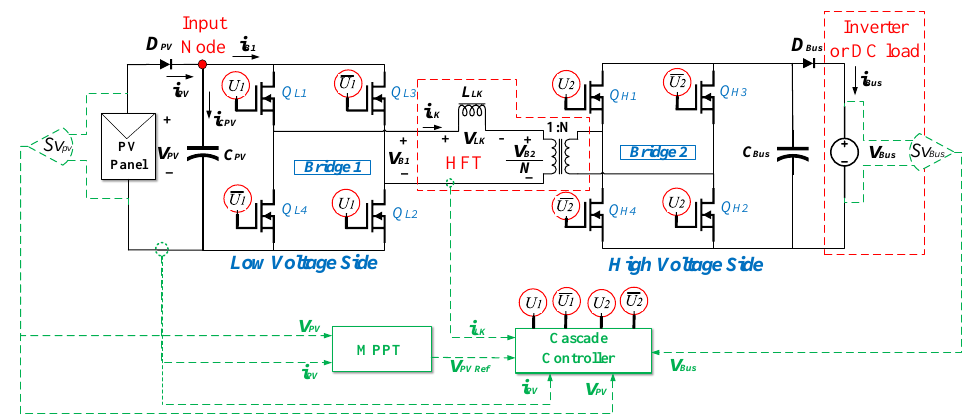
Figure 2. PV system based on a DAB converter.